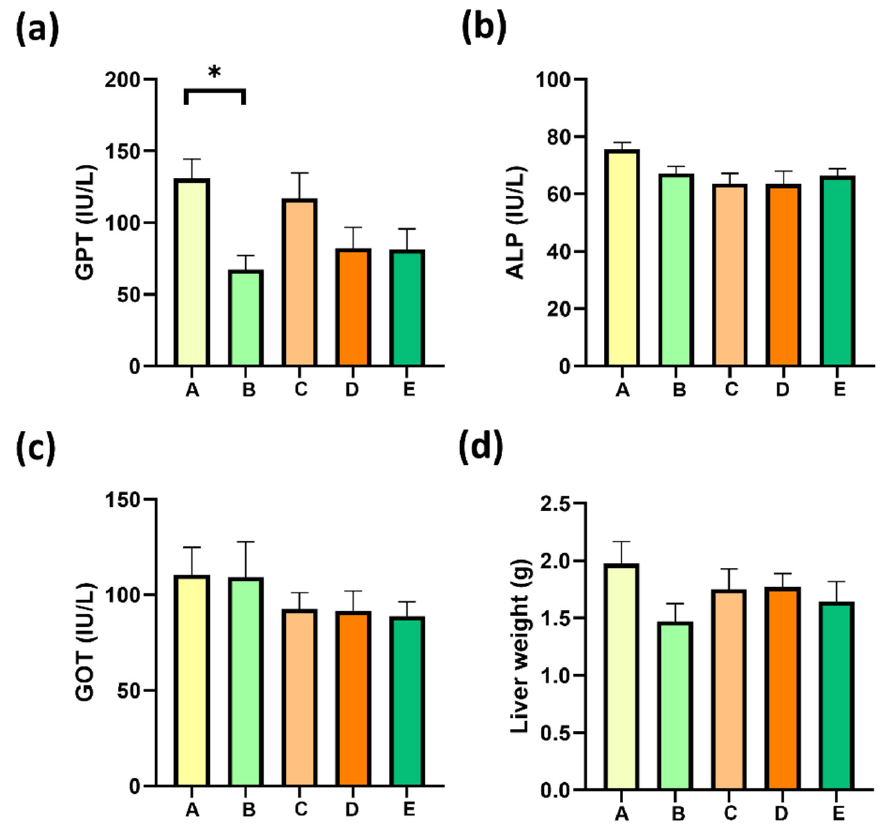
Figure 5. Effects of sPAG treatment on liver markers in obese mice. ( a ) glutamate–pyruvate